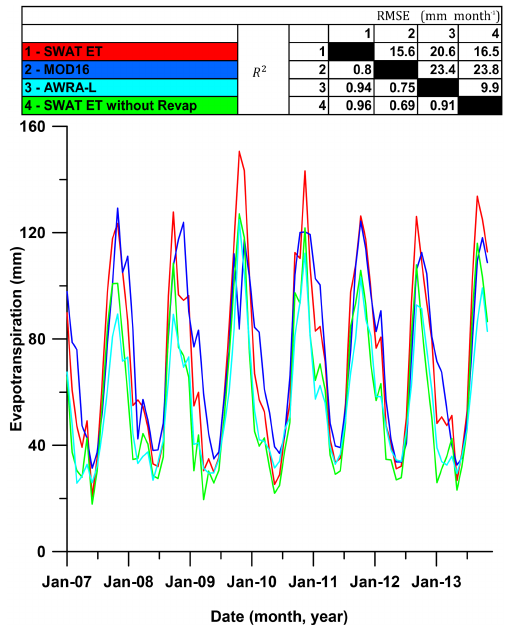
Figure 9. Monthly comparison of SWAT, AWRA-L and MOD16 ET at catchment scale.